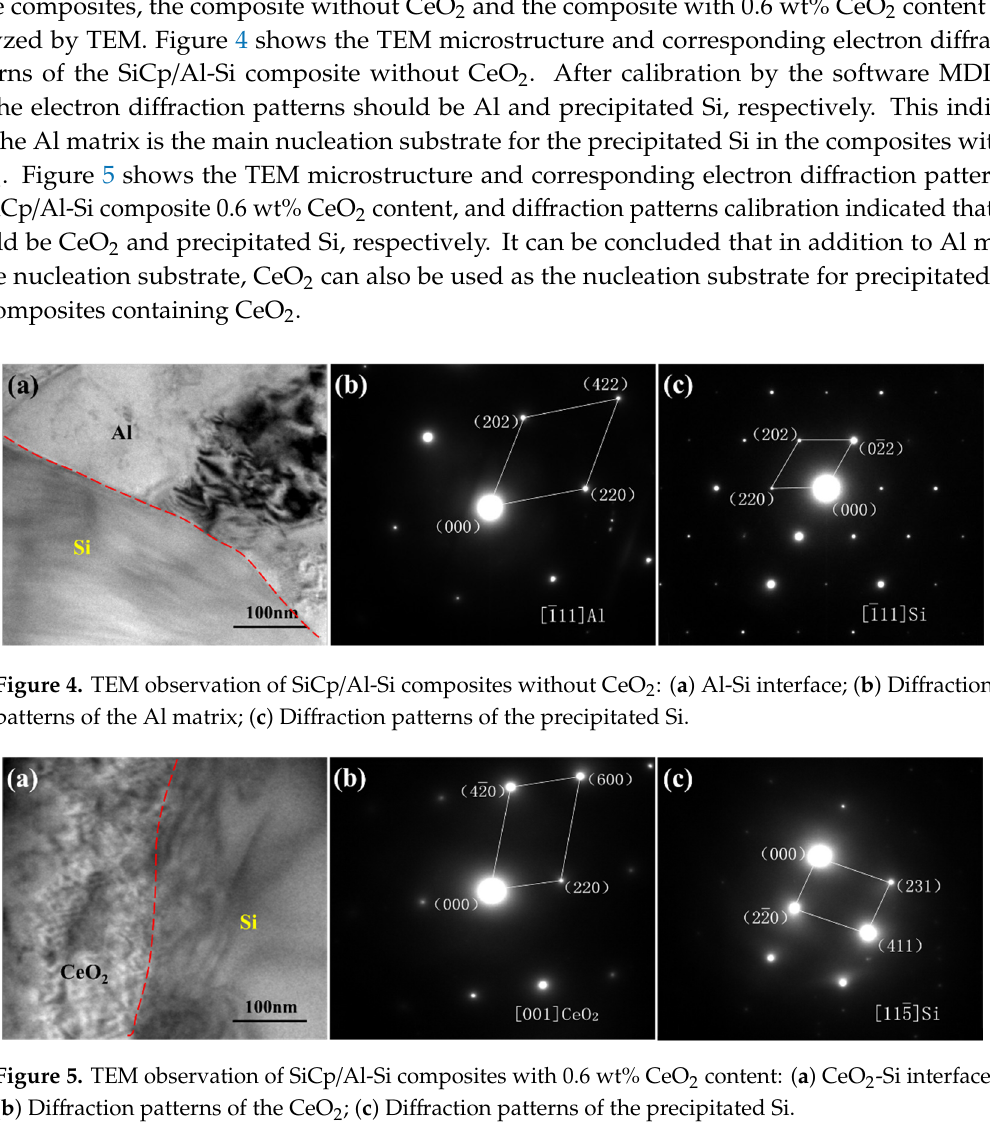
Table 1. Basic physical parameter of Si, CeO 2 and Al.